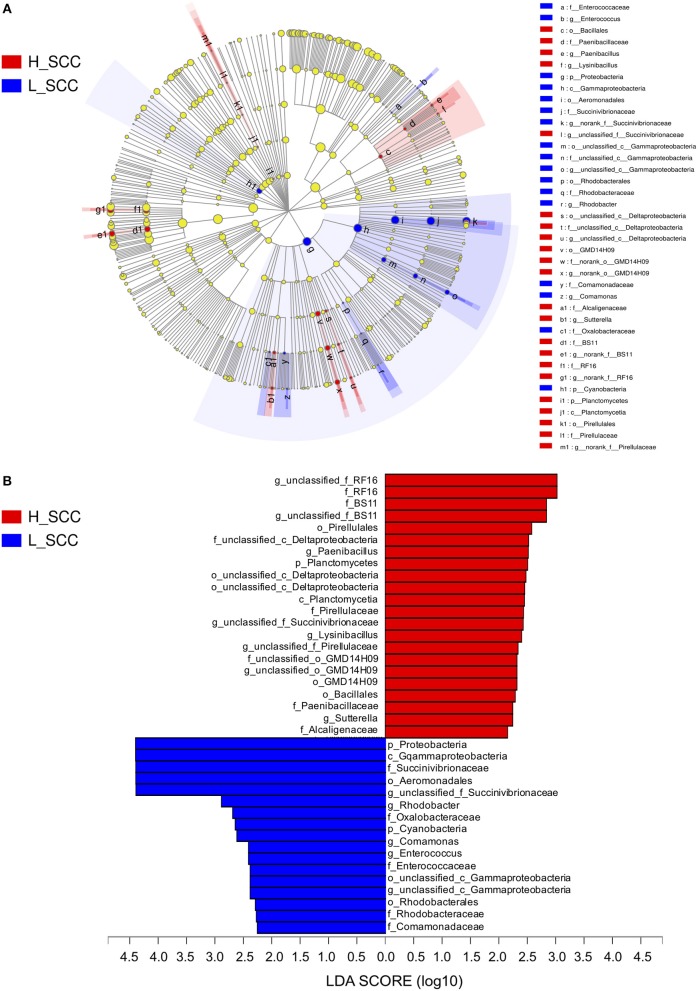
The LDA effect size (LEfSe) analysis of bacterial taxa between L_SCC and H_SCC groups. (A) Cladogram shows significantly enriched bacterial taxa (from phylum to genus level). (B) Bar chart shows LDA score of L_SCC and H_SCC groups. Significant differences are defined as P < 0.05 and LDA score > 2.0.